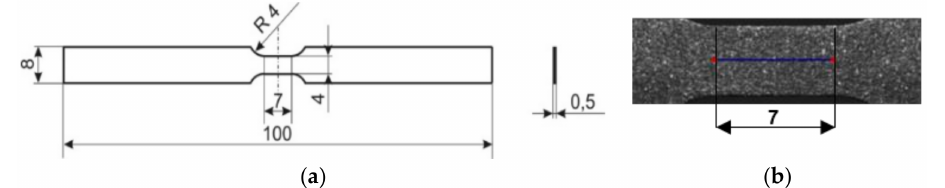
Figure 1. ( a ) Geometry and dimensions of Gum Metal specimen; ( b ) surface prepared for digital image correction (DIC) analysis with the denoted position of the virtual